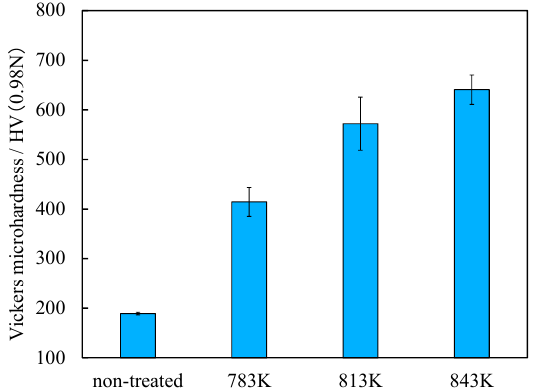
Figure 6. Surface hardness of ASPN-treated plate samples.